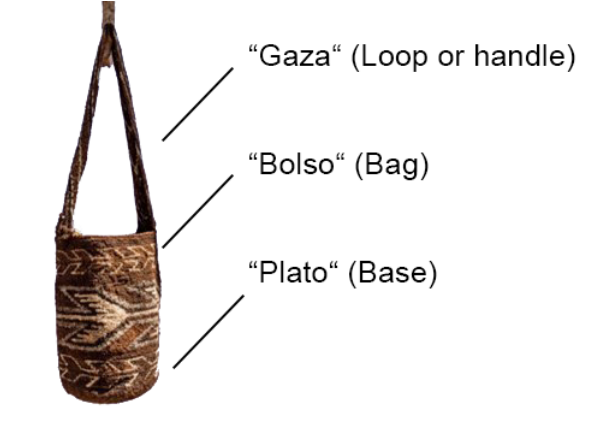
Figure 2. Mochila parts. Photo by Dwrya Izquierdo (2015).